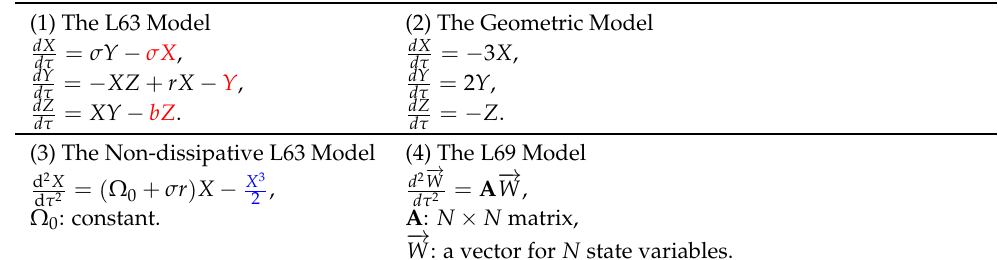
Table 3. The Lorenz 1963 (L63) model [1], the geometric model [59], the non-dissipative L63 model [29], and the Lorenz 1969 (L69) model [5]). The non-dissipative L63 model is derived from the L63 model without dissipative terms shown in red. For an extreme case of N = 1 and a positive eigenvalue, the L69 model is dynamically comparable to the non-dissipative L63 model without the cubic term shown in blue. A saddle point is a common feature amongst the four